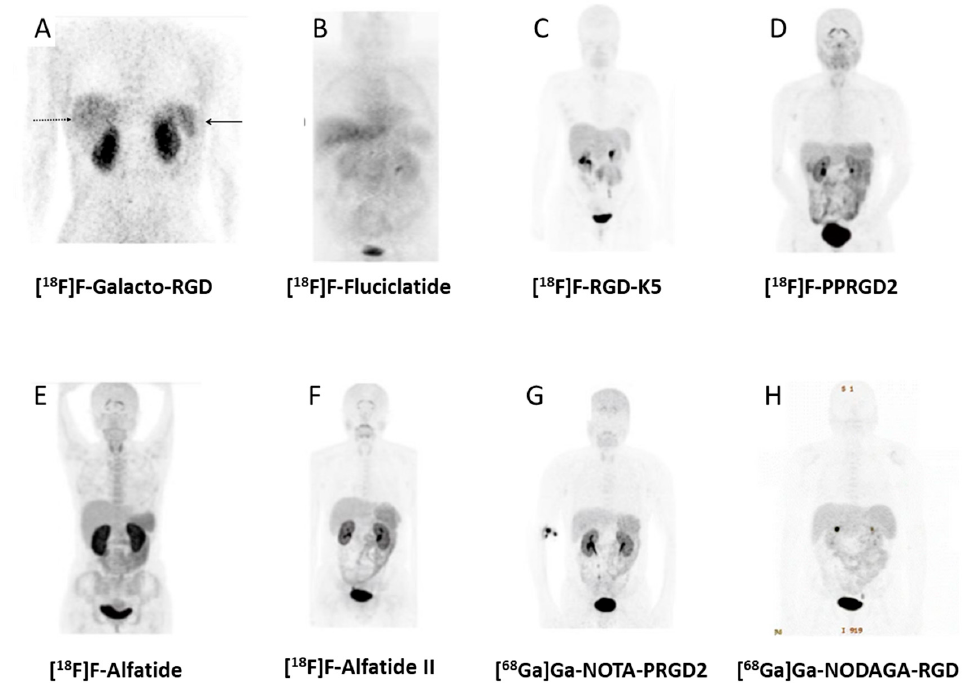
Figure 3. PET images of some clinically studied RGD-based tracers 1 h after intravenous administration in healthy volunteers ( B – D , F ), a patient with melanoma ( A ), scrofula ( E ), lung cancer ( G ), and hepatocellular carcinoma ( H ). All images are coronal views. High tracer retention is notable in urogenital tract, due to predominant renal clearance. Intermediate uptake is found in the liver, spleen, and intestines. Reproduced with the permission from [5,45,47,190,207–210].